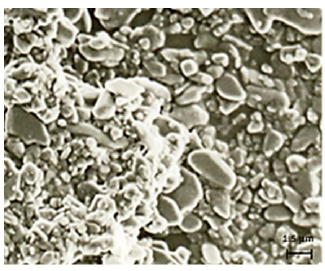
Figure 3. Scanning electron microscope (SEM) photomicrography of microspheres.